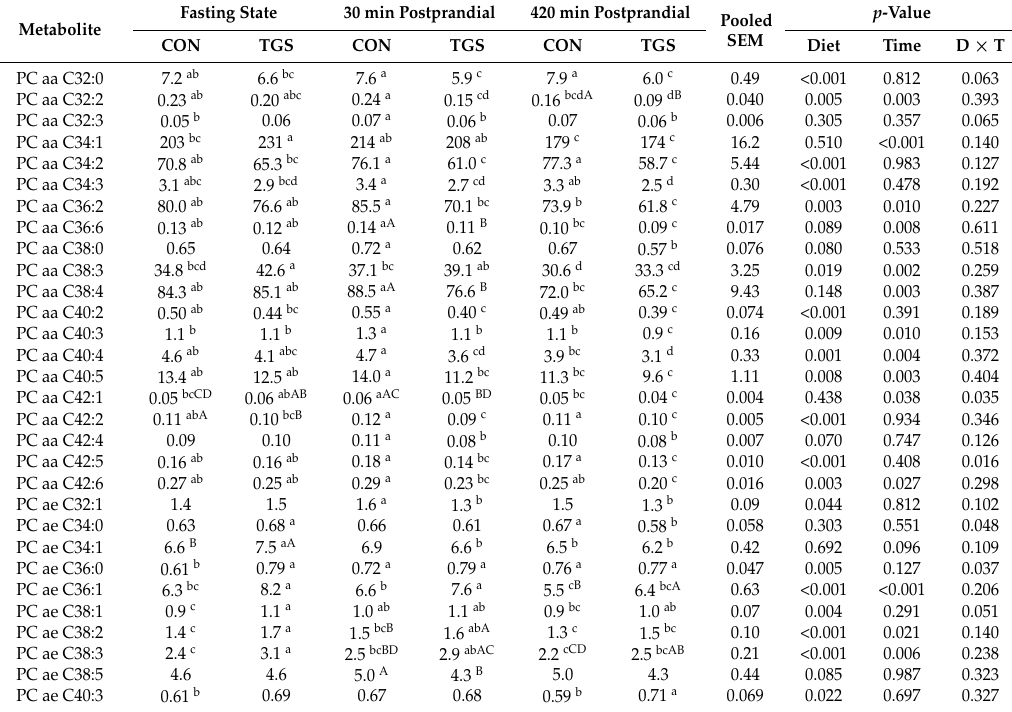
Table 4. Selected phosphatidylcholines ( µ mol/L) of pigs fed transglycosylated (TGS) or control (CON) starch diets pre- and